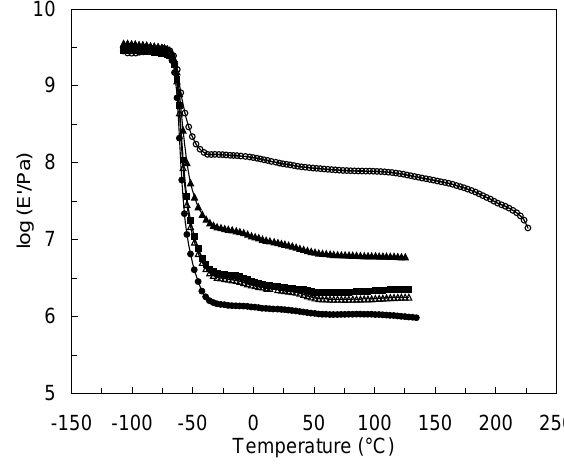
Figure 2. Logarithm of the storage tensile modulus E’ vs. temperature at 1 Hz for 10 wt % crab shell chitin whiskers reinforced natural rubber (NR) composites: unfilled NR matrix (  ), unmodified whiskers (  ), whiskers modified with alkenyl succinic anhydride (  ), whiskers modified with phenyl isocyanate ( ∆ ), and whiskers modified with isopropenyl- α - α ’-dimethylbenzyl isocyanate (  )